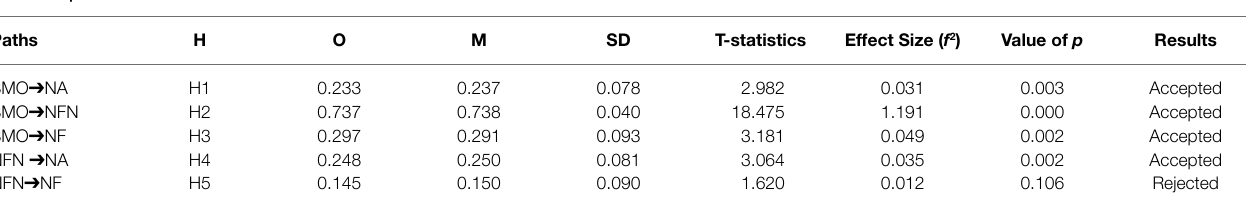
TABLE 6 | Direct effects of the